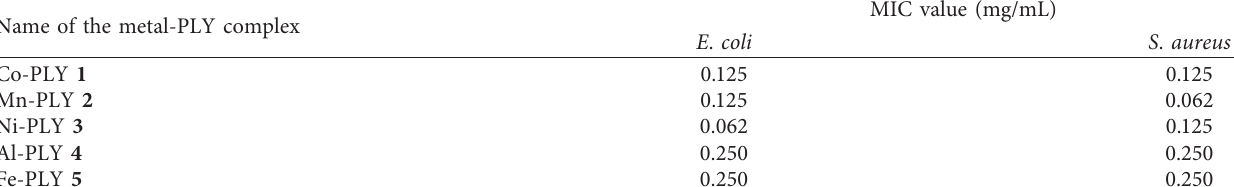
Table 3: MIC values of metal-PLY complexes (1 – 5) against E . coli and S . aureus.